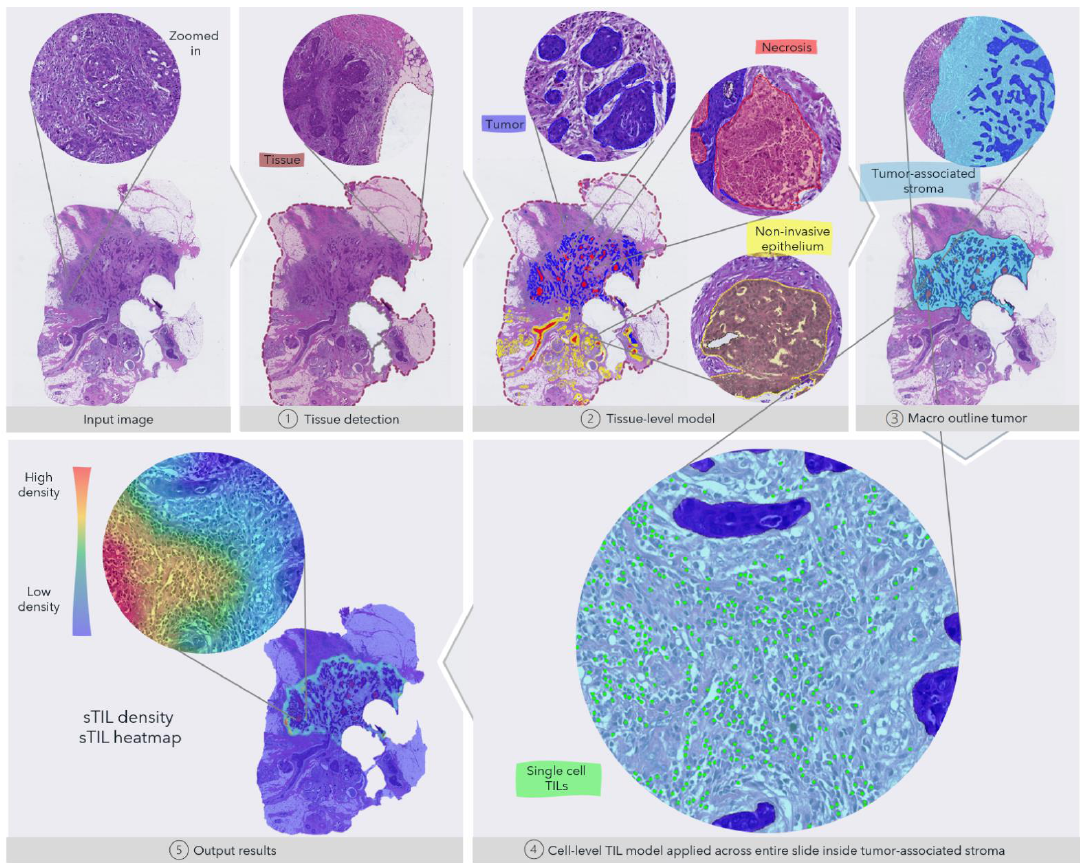
Figure 1. Overview of the fully automated image analysis pipeline. The input data are the scanned WSI of a TNBC patient, which is then analyzed by multiple steps. First, the tissue (dark red) is recognized from the glass to limit the analysis to only the relevant part of the scanned slide. Secondly, the tissue-level model classifies slide regions into tumor tissue (blue), non-invasive epithelium (yellow), and necrotic regions (red). In the third step, the macro-outline of the tumor is approximated, and then tumor-associated stroma and margin (turquoise) are defined. Cells across the entire sample in the tumor-associated stroma are classified as TILs (green) or not, and finally, the sTIL density and heatmap can be outputted for